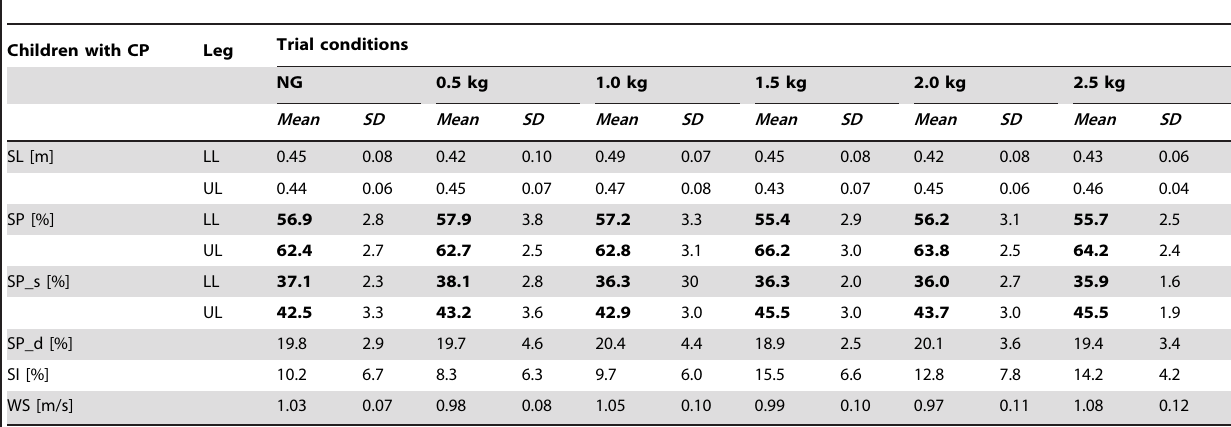
Table 2. Spatiotemporal parameters of loaded and unloaded leg for children with CP.